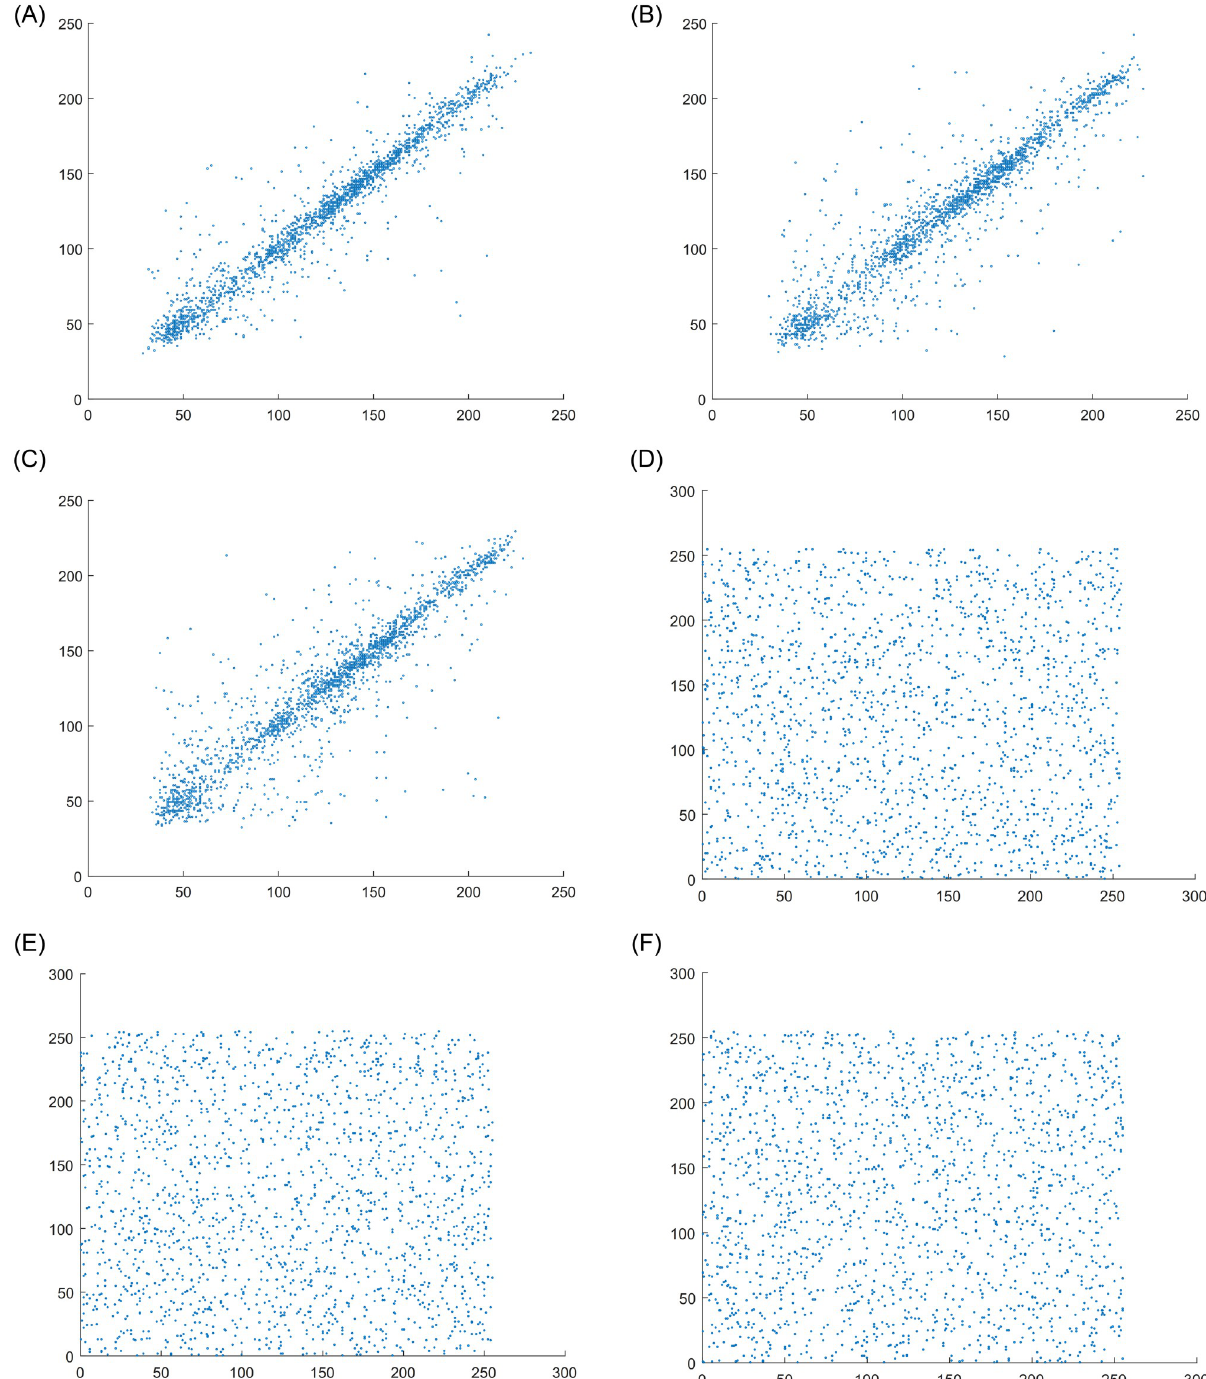
Fig 10. Pixel correlation analysis of plain image Peppers and corresponding encrypted image. A: Horizontal pixel of plain image. B: Vertical pixel of plain image. C: Diagonal pixel of plain image. D:Horizontal pixel of cipher image. E:Vertical pixel of cipher image. F:Diagonal pixel of cipher image.